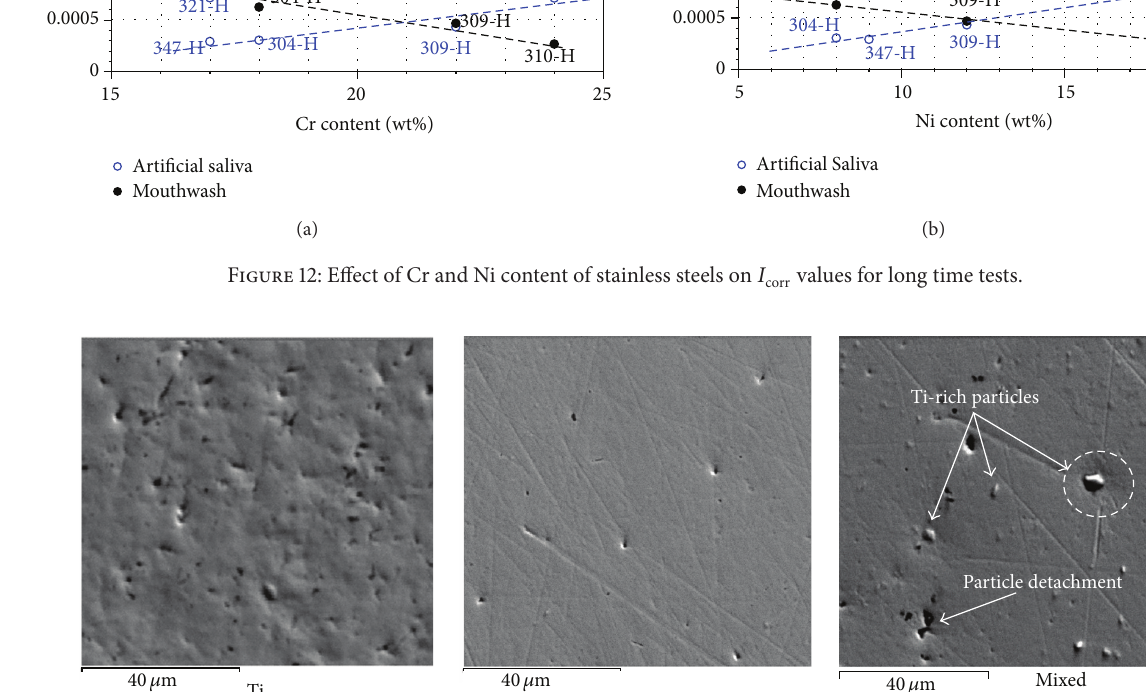
Figure 13: Superficial aspect for Ti, 310-H, and 321-H stainless steel after corrosion test in artificial